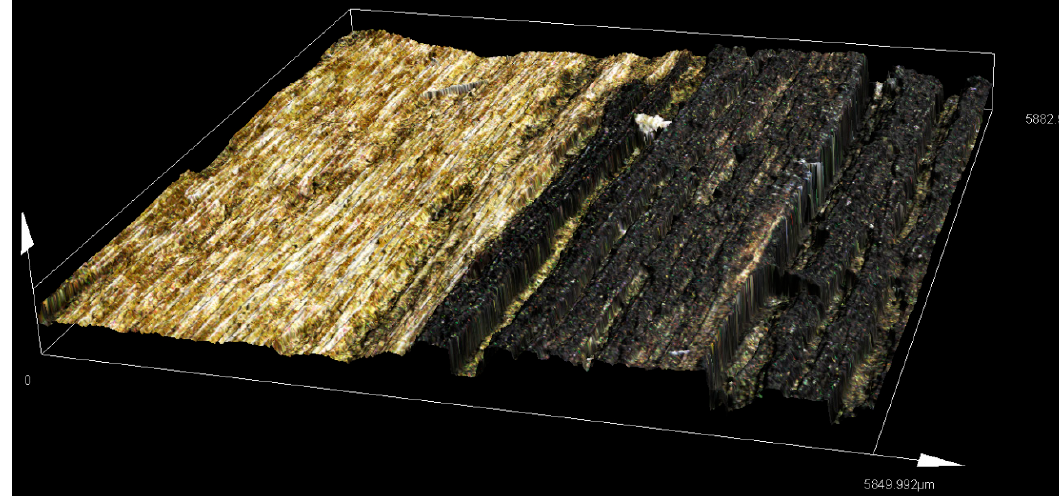
Figure 5. Laser confocal image of the surface of the spruce wood coated with an acrylic coating after five years of exposure. The remaining coating on the decking element is brown, while parts where the coating was removed remain lighter. The surface was severely damaged. Field of view 5850 × 5882 µm. Table 5. Decay rating of the decking elements determined according to EN 252 [24].